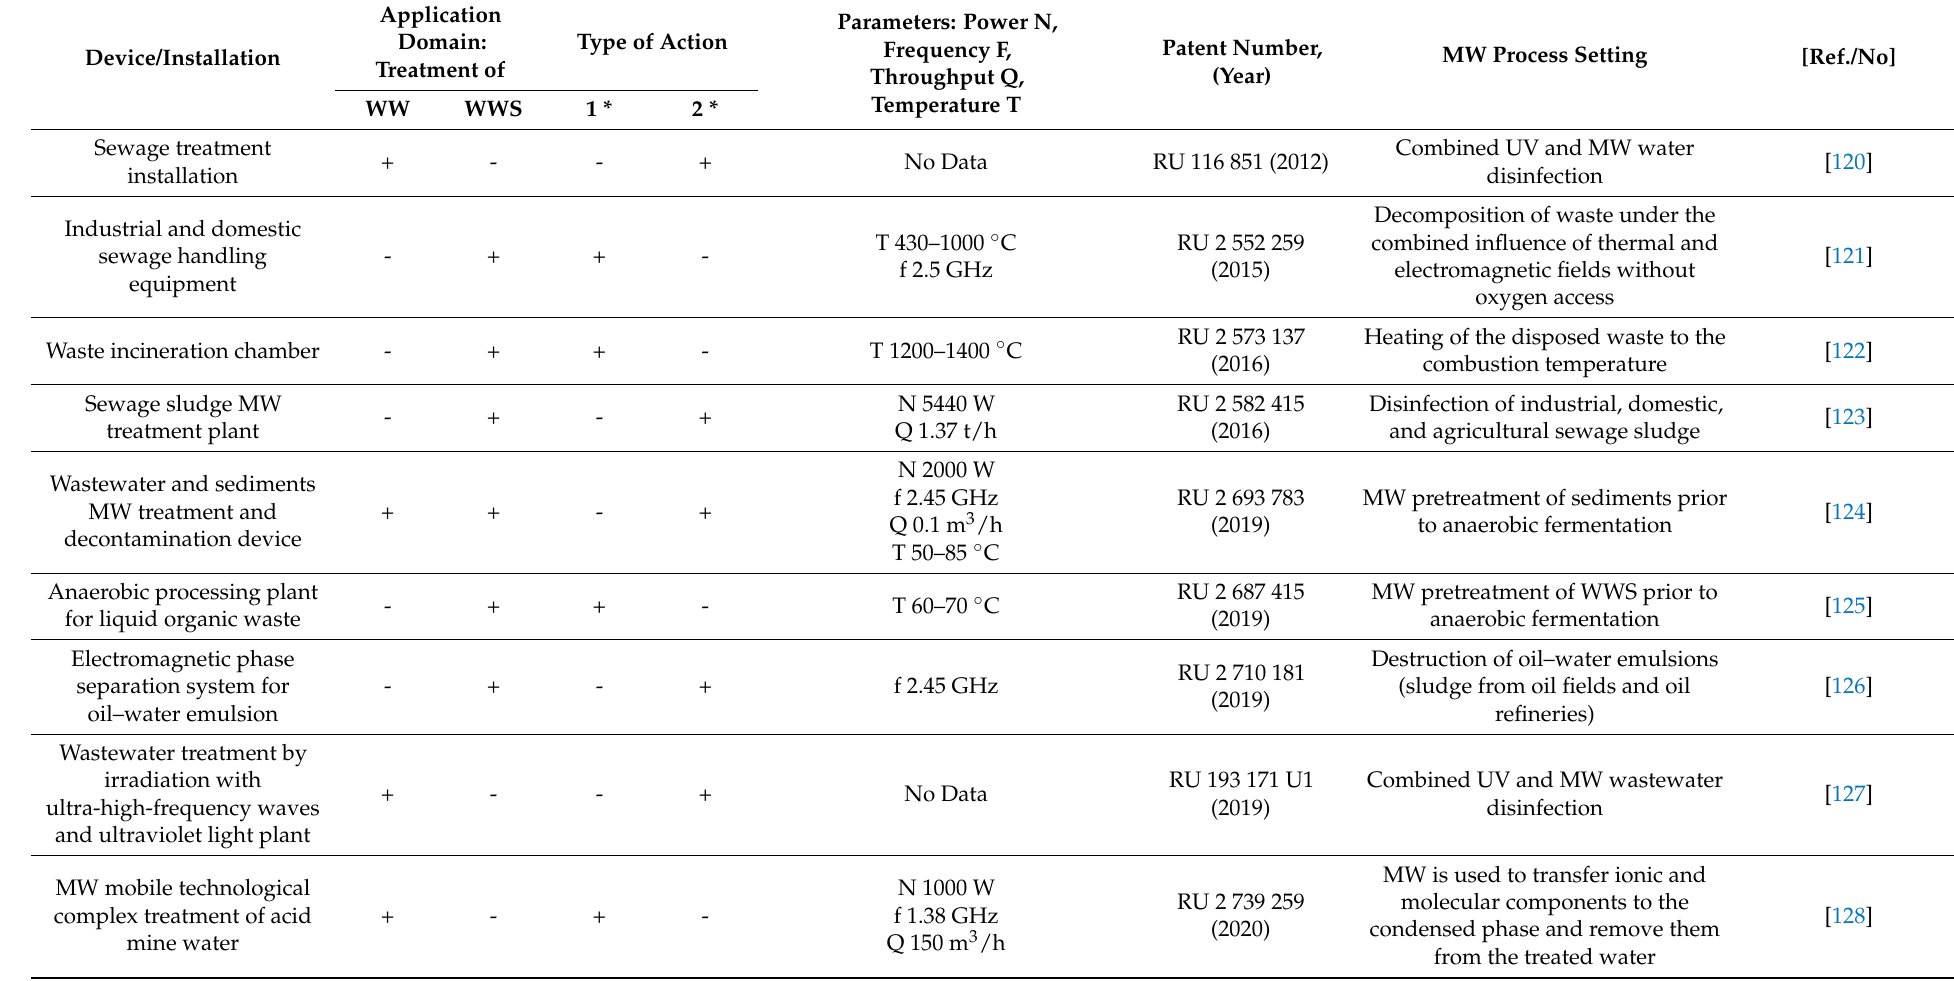
Table 11. MW installations/devices intended (or possible for use) for wastewater and sediments treatment